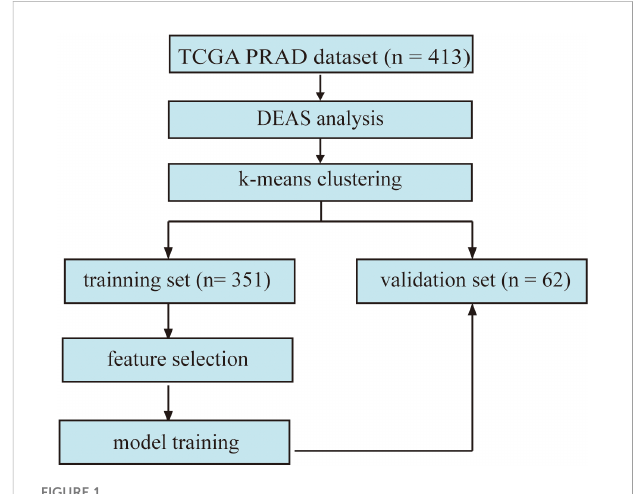
FIGURE 1 The fl owchart displays the framework of our study. (DEAS: differentially expressed alternative